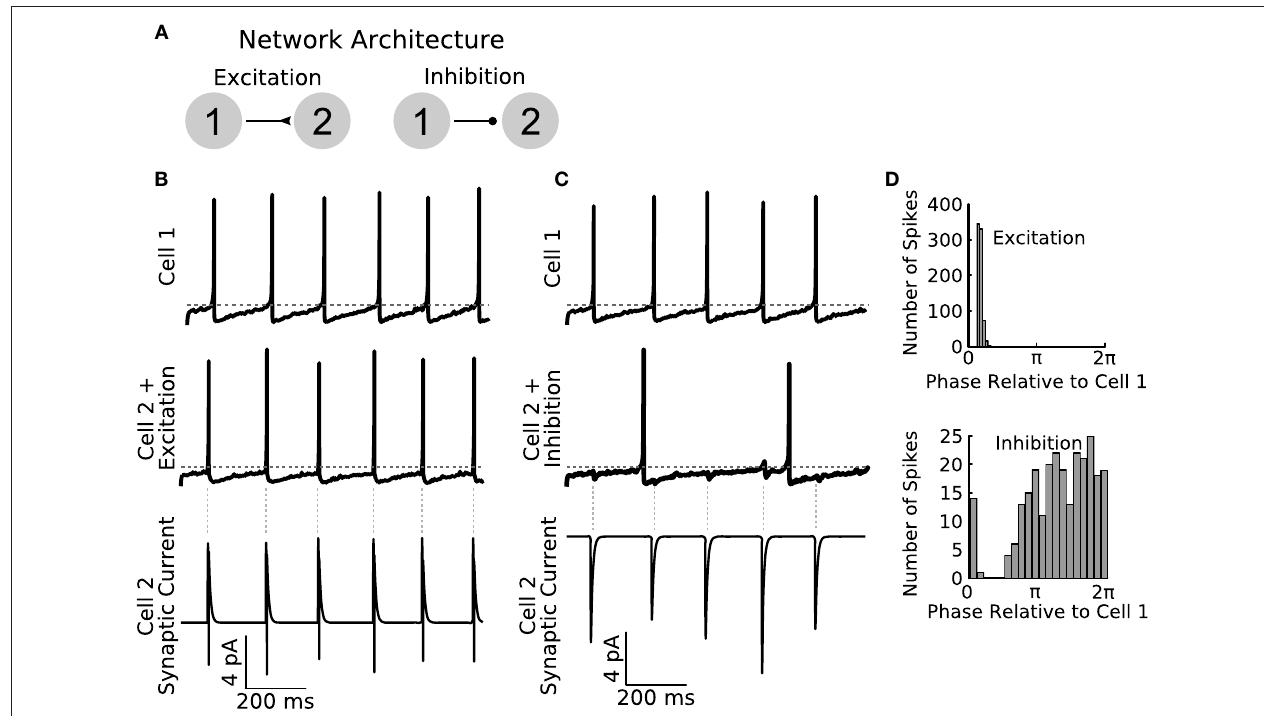
network can be run with the synapse switched to be inhibitory. In this case, post-synaptic spiking in Cell 2 is irregular and does not track pre-synaptic spiking (middle panel). The effect of pre-synaptic spikes (top panel) on the post-synaptic voltage can be observed as small, hyperpolarizing deflections in the voltage. Spiking in Cell 2 occurs when the natural evolution of the voltage overcomes the periodic inhibition from Cell 1. As a result, firing in Cell 2 is slower than when inputs were excitatory. (D) Spike time histograms (plotted as Cell 2 spike times relative to the phase of Cell 1) show the distribution of spikes in Cell 2 depending on the coupling type used. Excitation causes Cell 2 to become entrained to Cell 1 (top panel) and Cell 2 spike occur in a small time window only. Inhibition causes spiking in Cell 2 to be biased to occur in the second half of the Cell 1 period when inhibition has had sufficient time to wear off (bottom panel) but overall spikes are spread over a wider time window than when excitation